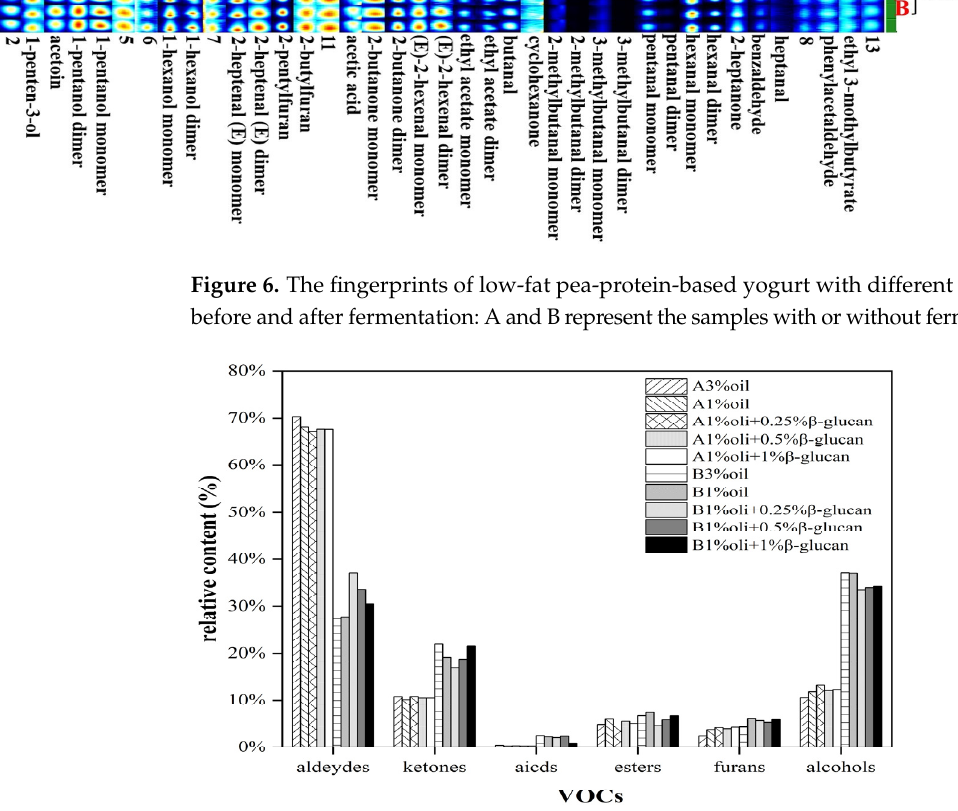
Figure 7. The relative content of pea-protein-based yogurt with di ff erent levels of oat β -glucan be- fore and after fermentation: A and B represent the samples with or without fermentation, respec- tively.